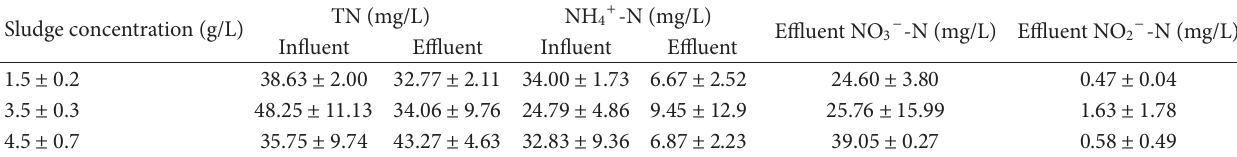
T 3: Nitrogen removal in a DSTR at different sludge